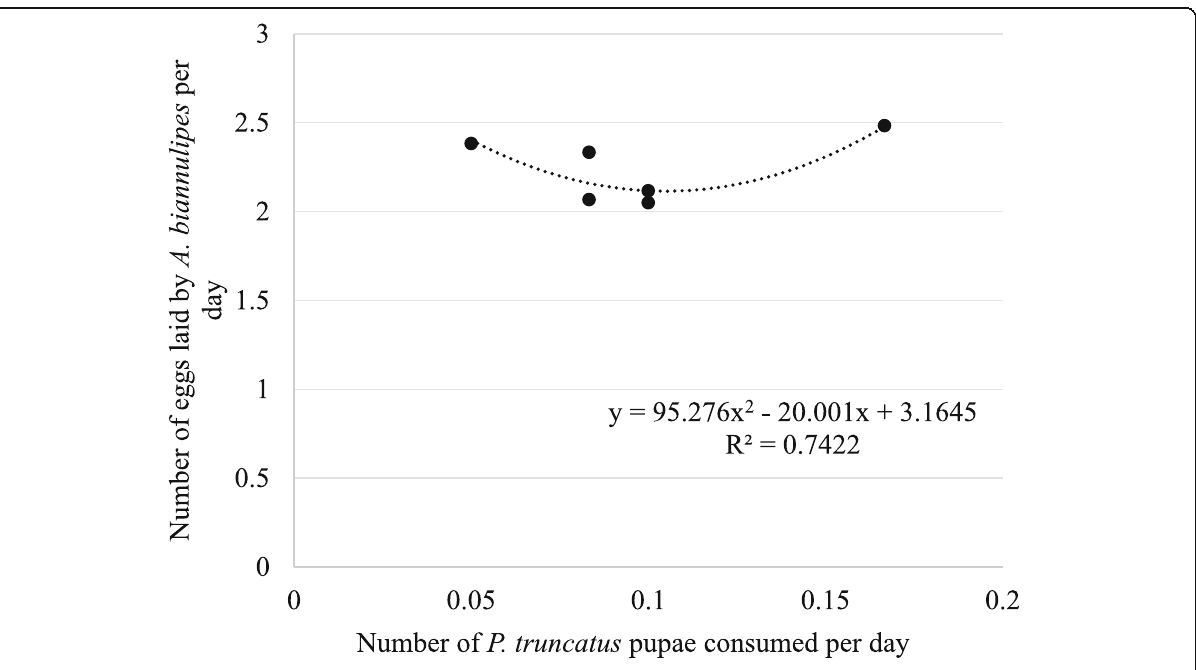
Fig. 7 Average number of eggs laid per female A. biannulipes based on P. truncatus pupae consumed per